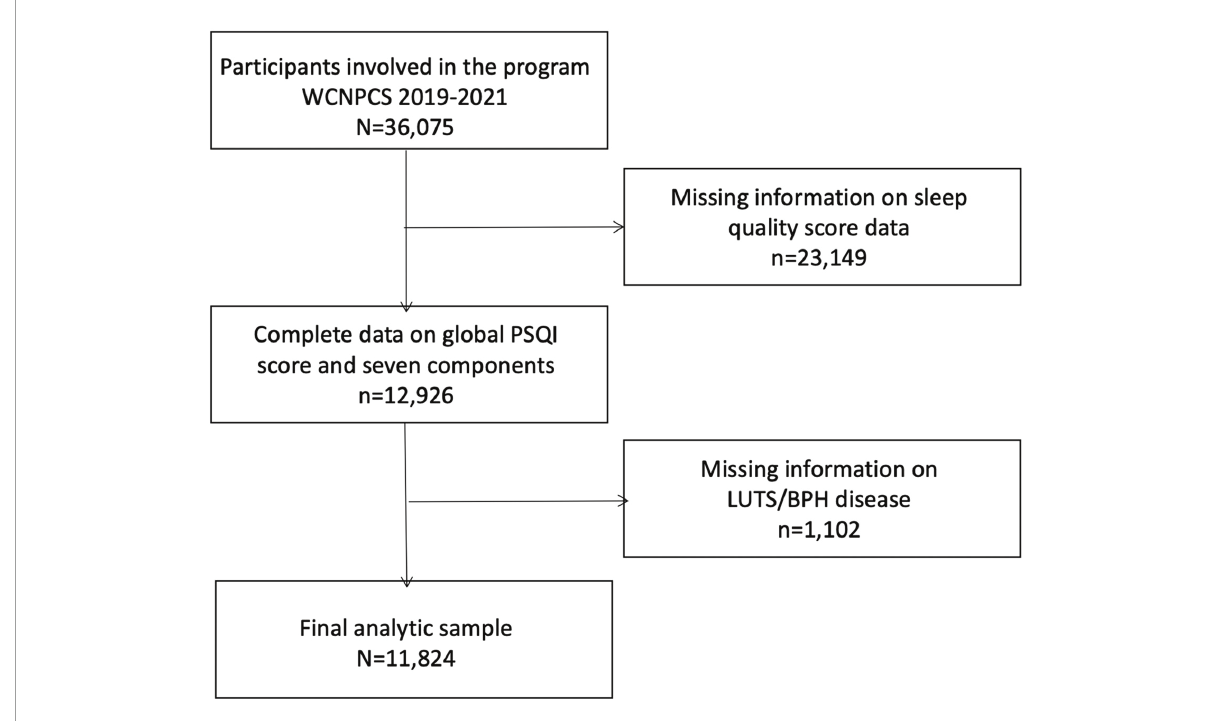
FIGURE1 Flowchart of participant inclusion and exclusion for